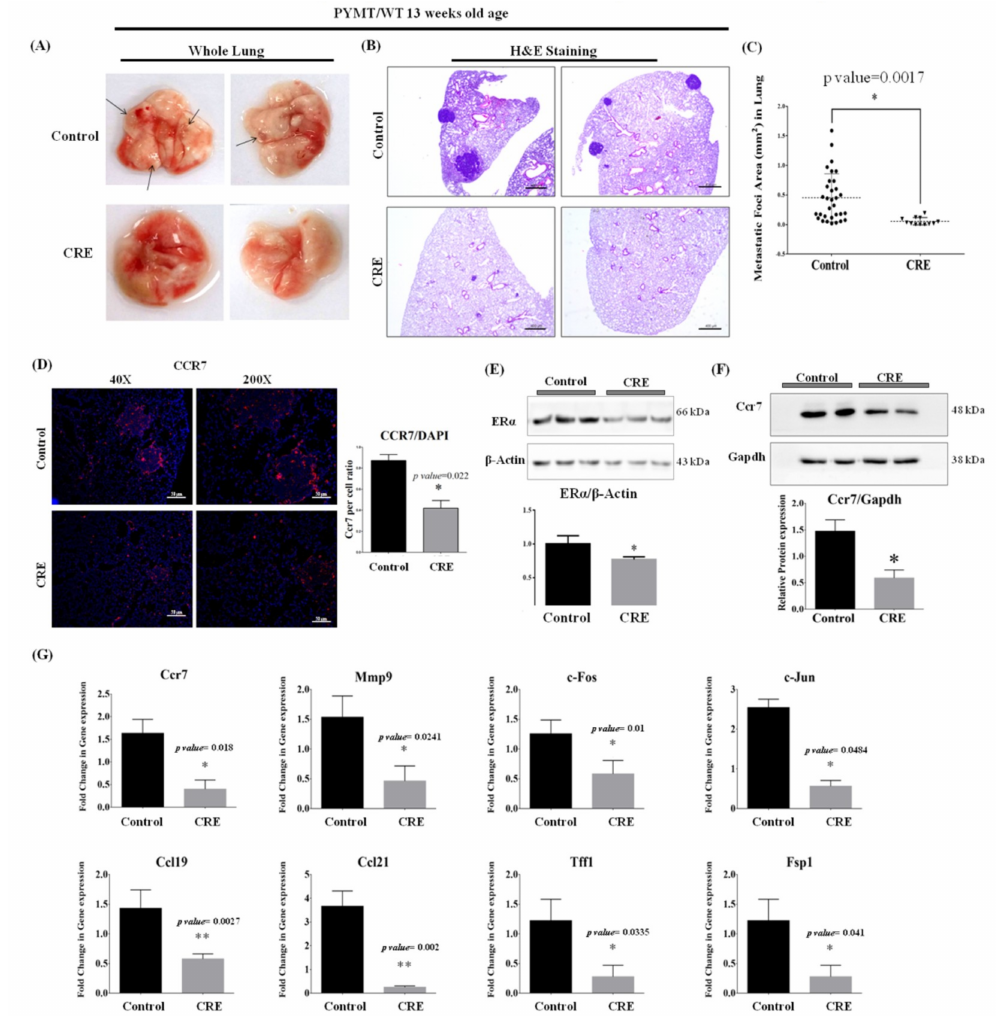
Figure 5. Gross and histological appearance of lung excised from 13 weeks of age PyMT transgenic females. CRE treated PyMT transgenic females showed decreased frequency of mammary tumor-derived lung metastases. ( A ) Representative photos of whole lung excised from 13 weeks age of control group (upper side) and CRE group (bottom side). Larger and more visible metastatic foci were observed in control group. ( B ) Hematoxylin and eosin (H&E) staining was done with lung samples excised from 13 weeks of age PyMT transgenic females with/without CRE treatment. Slides were microscopically examined and images taken. The number and size of metastases significant decreased in PyMT transgenic females with CRE treatment Scale bars = 400 µ m. Curcumae radix extract suppresses frequency of PyMT mammary tumor-derived lung metastases and tumorigenesis by inhibiting CCR7 and its downstream genes in lung of PyMT transgenic mouse. ( C ) The distribution of sizes of metastatic foci in control group ( n = 7) and CRE group ( n = 6) lungs as mean ± SEM. * emphp < 0.05 vs. control. ( D ) Immunohistochemistry staining against Ccr7 in lung tissues was done and representative images of tissue sections from each group were taken at 200X and 40X magnification. Scale bars = 50 µ m. Histogram data was presented as mean ± SEM. * p < 0.05 vs. control. ( E ) Western blot of proteins extracted from lung tissues against ERalpha and β -actin. * p < 0.05 vs. control. ( F ) Level of Ccr7 protein in lung tissues was analyzed by Western blot. Gapdh was used as an internal control. * p < 0.05 vs. control. ( G ) To investigate level of transcripts associated with breast cancer metastasis the expression levels of Ccr7, c-Fos, Mmp9, Ccl21, Ccl19, Ps2, Fsp1 and Jun were monitored by qRT-PCR. β -actin gene was used as an internal control in real time PCR. Values represent means ± S.E.M. n = (3); * p < 0.05 and ** p < 0.005 vs.